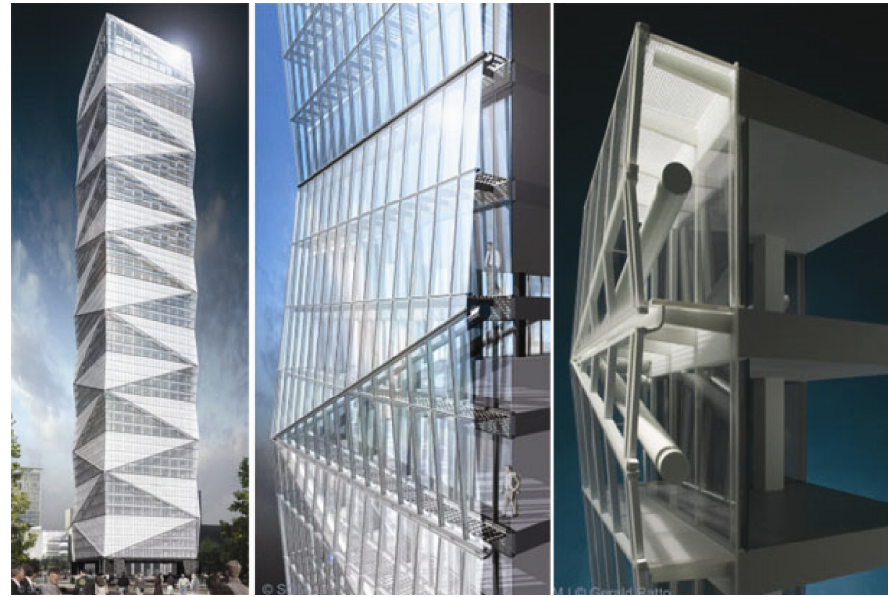
Fig. 3. Jinao Tower in Nanjing, China (courtesy of Skidmore, Owings & Merrill